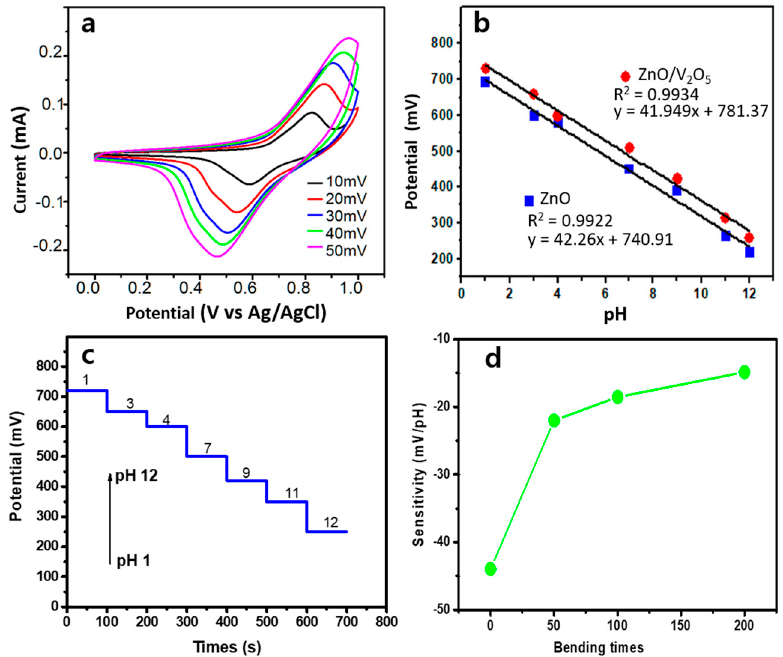
Figure 7. ( a ) Cyclic voltammetry curve of ZnO/V 2 O 5 electrode at different scan rates in NaOH/HCl mixture of pH 4, ( b ) calibration plot for ZnO and ZnO/V 2 O 5 pH sensors with a straight line representing the linear fit, ( c ) potential–time response obtained on increasing the pH of NaOH/HCl electrolyte at ZnO/V 2 O 5 electrode, and ( d ) calculated sensitivity after various bending cycles to validate the mechanical stability of ZnO/V 2 O 5 pH sensors.